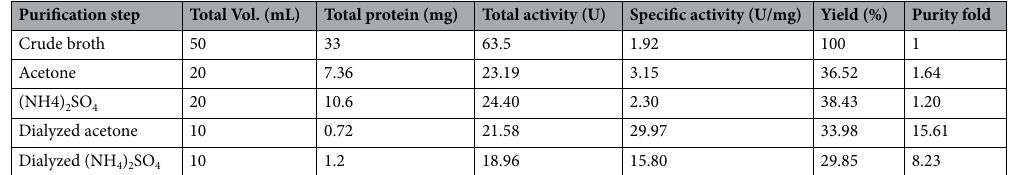
Table 4. The partial purification summary of alkaline Pectate